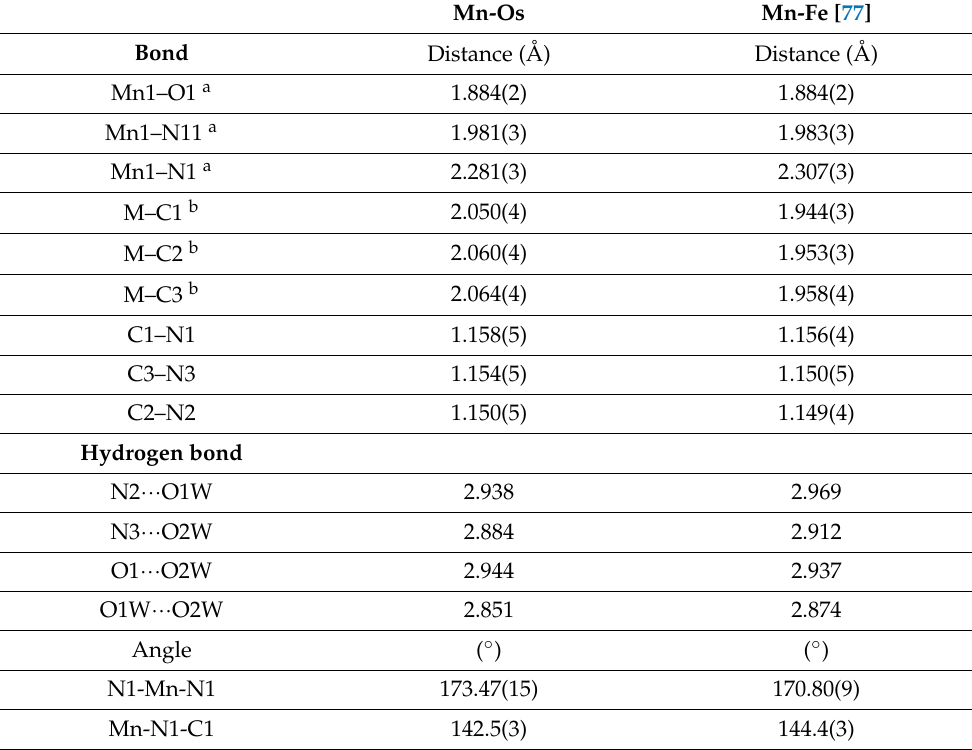
Figure 2. View of the chain motif of 1 projected along a axis. Hydrogen atoms and interstitial water molecules have been omitted for clarity. The axes denote overlap with atoms. Table 1. Selected geometric parameters for [Mn(SB 2+ )Os(CN) 6 ] · 4H 2 O ( 1 ). Mn-Os Mn-Fe